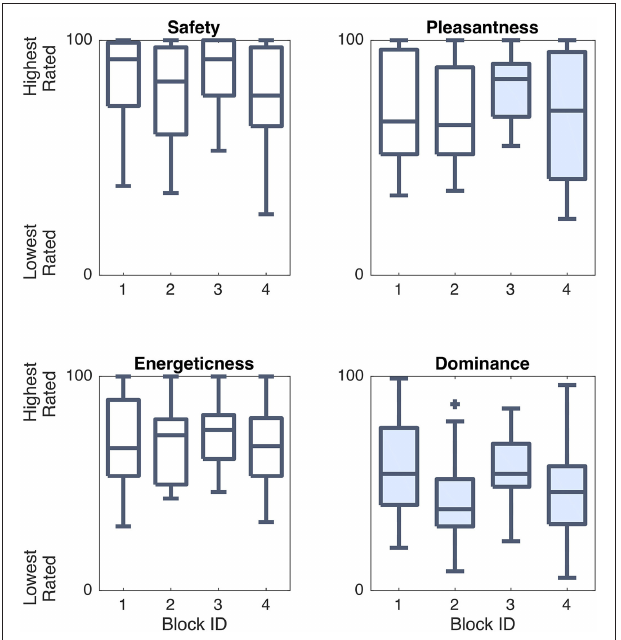
FIGURE 8 | Differences in responses to the PADS survey questions across interaction blocks. Shaded boxes are significantly different from at least one other condition.